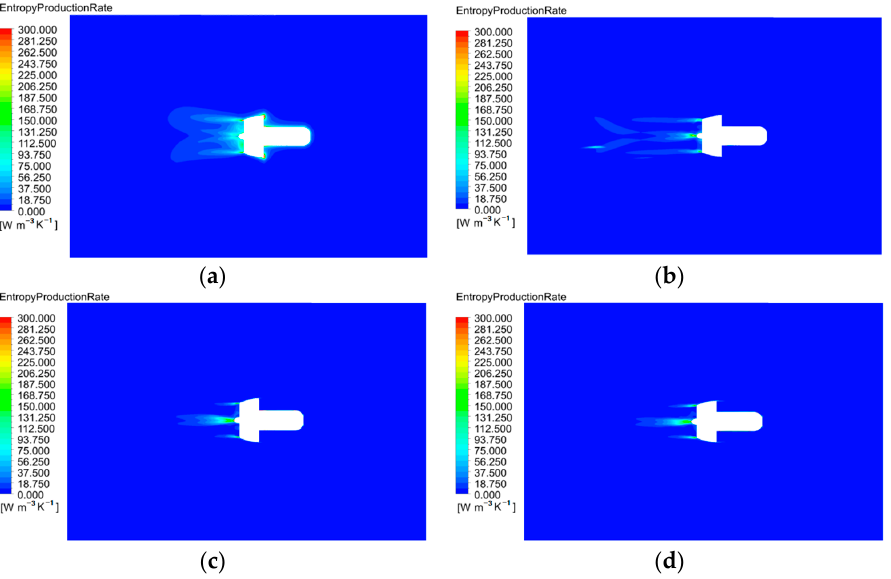
Figure 11. Entropy distribution of different navigational speed with 2000 r/min impeller rotational speed. ( a ) 0 m/s; ( b ) 0.37 m/s; ( c ) 1.54 m/s; ( d ) 2.057 m/s.